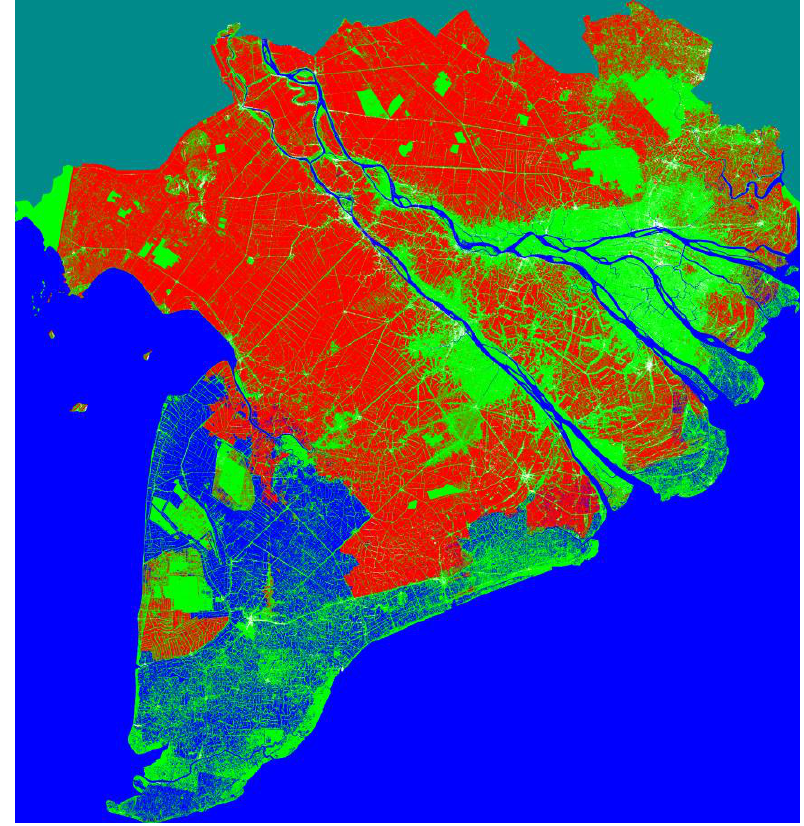
Figure 3. Land-cover map in the Mekong River Delta (Vietnam) for the 2015 spring-summer rice season derived from Sentinel-1A data (mode IWS). The land-cover map at 20 m resolution features rice production (red), non-rice (green) (e.g., other land use type such as trees, orchards, and other crops), water bodies (blue) (including sea, river, aquaculture), and land outside the Mekong delta (grey). The total rice planted area during this rice season is estimated to be 2.14 Million hectares by 21 July 2015. Copernicus Sentinel data